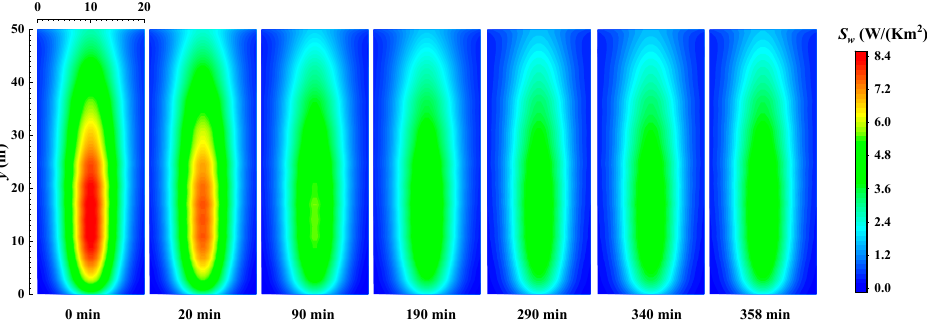
Figure 6. The distribution of the local REG rate on the wall when burning sub-bituminous coal (Wy- oming).